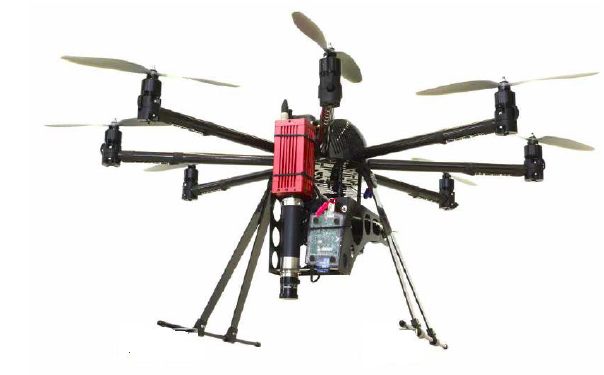
Figure 1. Aerialtronics Altura AT8 octocopter UAV with HYMSY